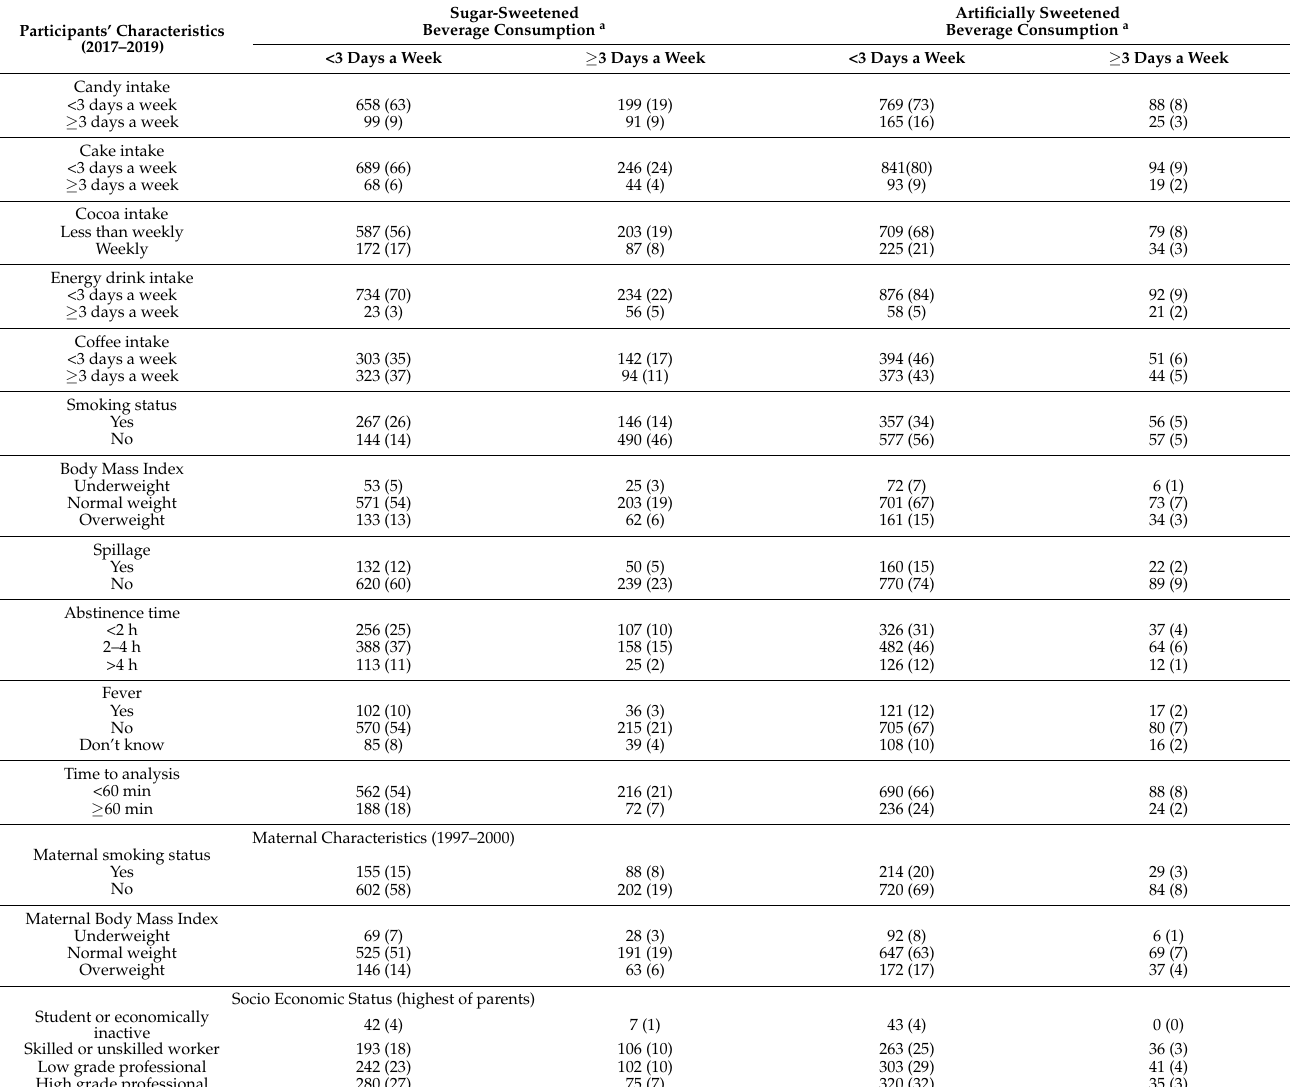
Table 1. Characteristics of the 1047 participants sorted by beverage consumption, with available information on sugar-sweetened, artificially sweetened beverage consumption and semen parameters, and maternal characteristics, FEPOS